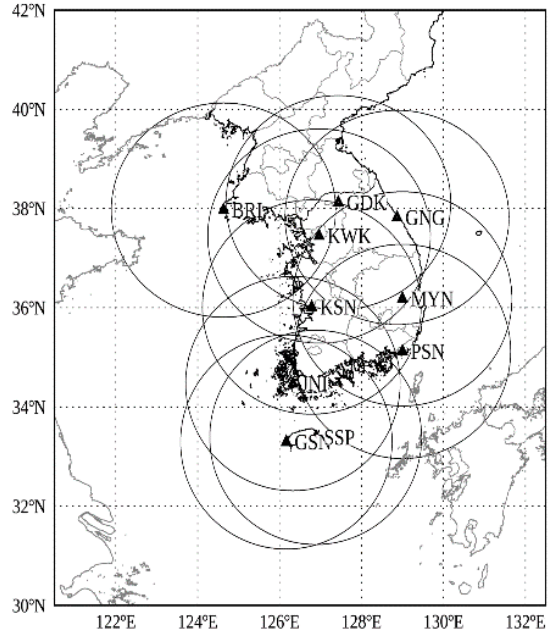
Figure 1. Deployment of the Korea Meteorological Administration (KMA) S-band dual-polarization weather radar network. The 10 circles indicate the 240 km radius coverage of the radar. Table 1. Scan strategy of KMA operational S-band dual-polarization radars.